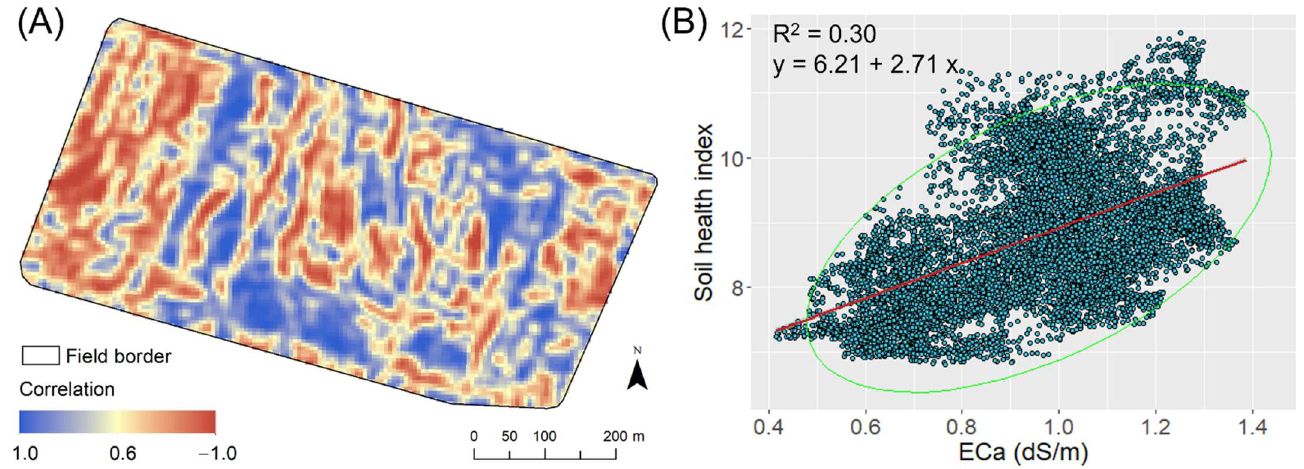
Figure 5. ( A ) Local correlation map between apparent electrical conductivity (ECa) and soil health index, and ( B ) a linear relationship between the two. Data points in 5B correspond to all the predicted pixels at 5 m grid resolution, continuous line with the shaded area are a linear fit and the standard error, and the green eclipse shows a 95% prediction eclipse.